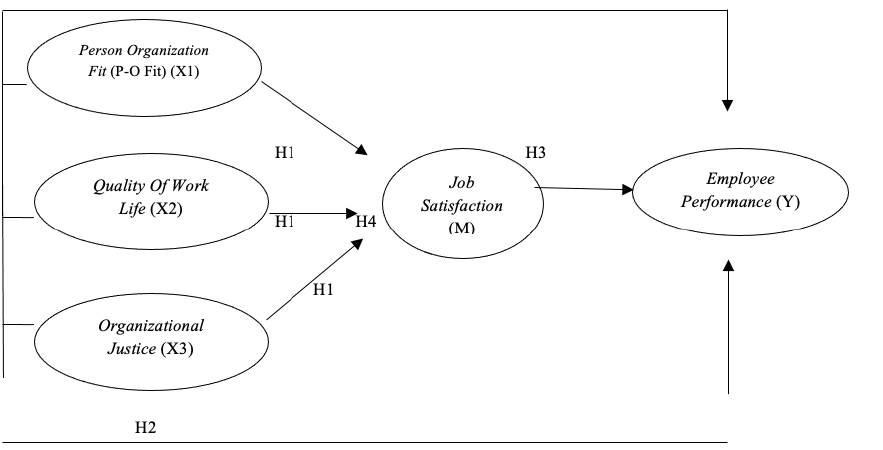
Figure 1: Relationship of Person Organization Fit (PO Fit), Quality of Work Life, and Organizational Justice to Job